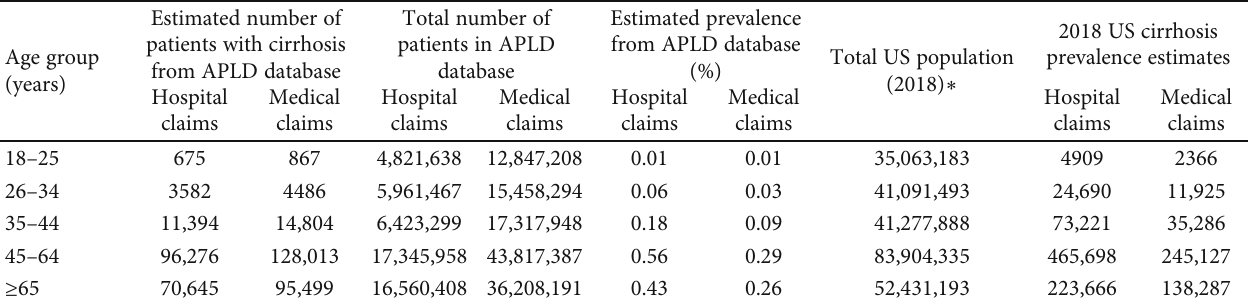
Table 3: Estimation of cirrhosis prevalence rates by age group and projection to estimated cirrhosis prevalence in the US population.